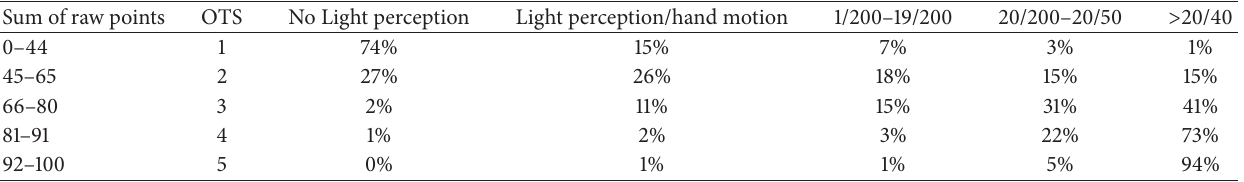
Table 3: Conversion of raw points into OTS category and calculating the likelihood of the final visual acuity in five categories. The Ocular Trauma Score (OTS). Reproduced from Kuhn et al.